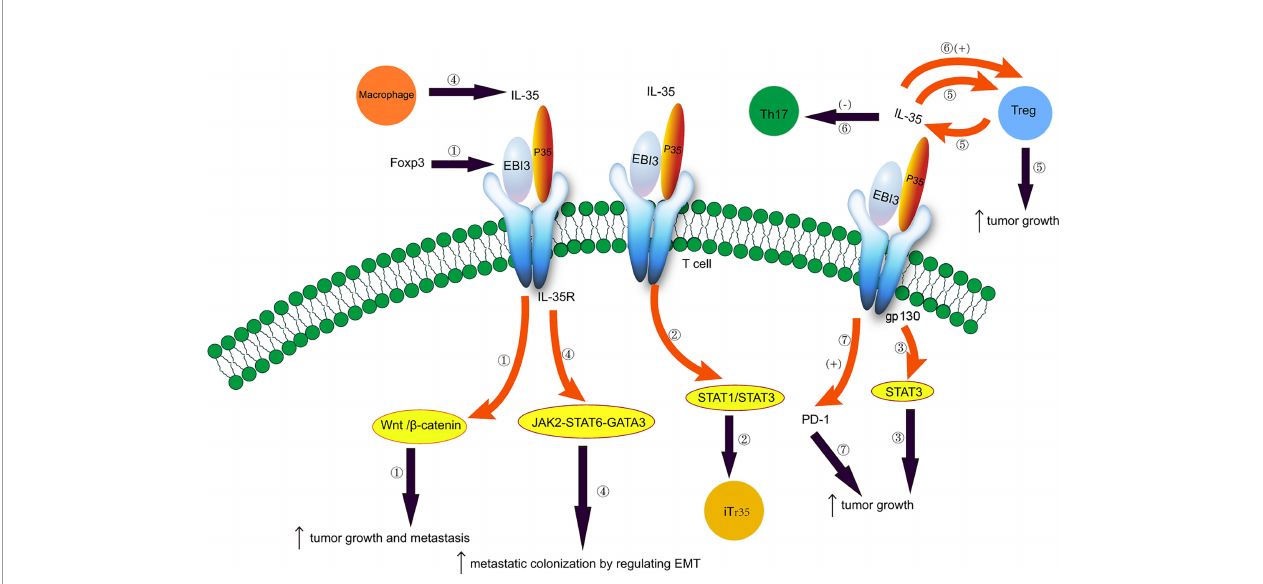
FIGURE 1 | Potential role of IL-35 in non-small cell lung cancer. 1. Foxp3 targets the EBI3 subunit of IL-35 and induces tumor growth and metastasis by activating the Wnt/ b -catenin signaling pathway. 2. IL-35 induces the conversion of conventional T cells to iTr35 through the STAT1/STAT3 pathway. 3. EBI3 promotes tumor growth through the gp130-STAT3 signaling. 4. Tumor-associated macrophages secrete IL-35 and promote metastatic colonization by regulating epithelial- mesenchymal transition through the JAK2-STAT6-GATA3 signaling pathway. 5. IL-35 is secreted by Treg cells, and IL-35 produced by cancer cells recruits Treg cells and induces tumor growth. 6. Imbalances between Treg and Th17 cells. IL-35 plays an immunosuppressive effect by promoting Treg proliferation and inhibiting Th17 cell differentiation. 7. IL-35 produced by Treg cells induces the expression of PD-1 and other inhibitory cytokines, impairing T cell function in the tumor environment and promoting tumor